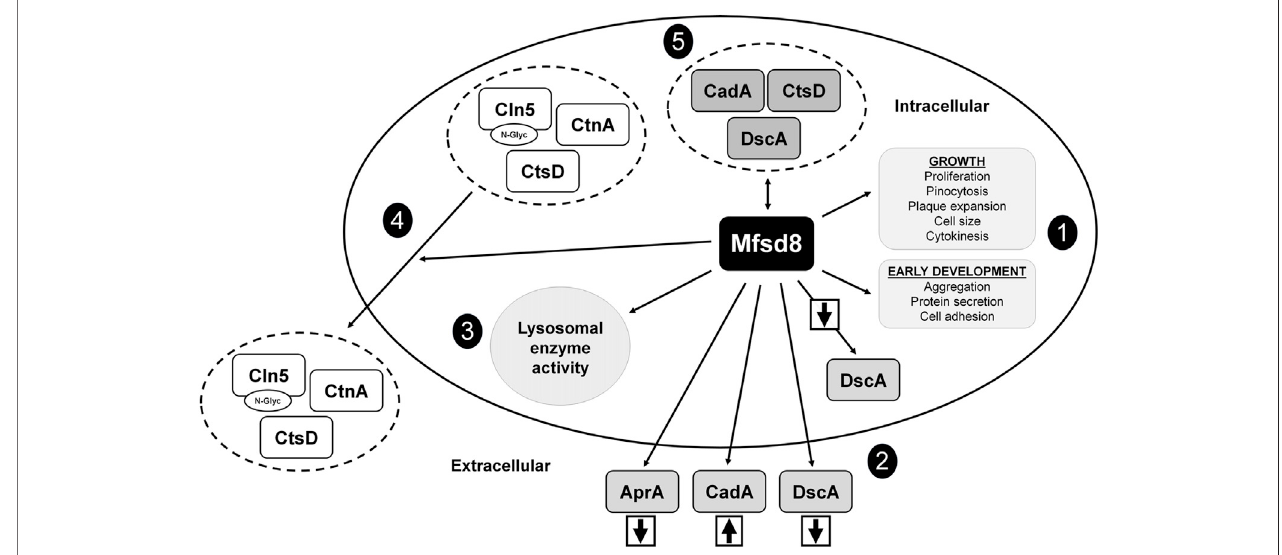
FIGURE 10 | Current model depicting the functions of Mfsd8 in D. discoideum . (1) Loss of mfsd8 affects cell proliferation, pinocytosis, plaque expansion, cell size, and cytokinesis during growth, and aggregation, protein secretion, and cell adhesion during the early stages of development. (2) Loss of mfsd8 reduces the intracellular and extracellular amounts of DscA during the early stages of development and increases the extracellular amount of CadA. Loss of mfsd8 decreases the extracellular amount of AprA during growth. (3) Loss of mfsd8 affects lysosomal enzyme activity during growth and the early stages of development. (4) Mfsd8 regulates the secretion of Cln5, CtsD, and CtnA during the early stages of development. (5) Mfsd8 interacts with CadA, CtsD, and DscA during growth and the early stages of development.